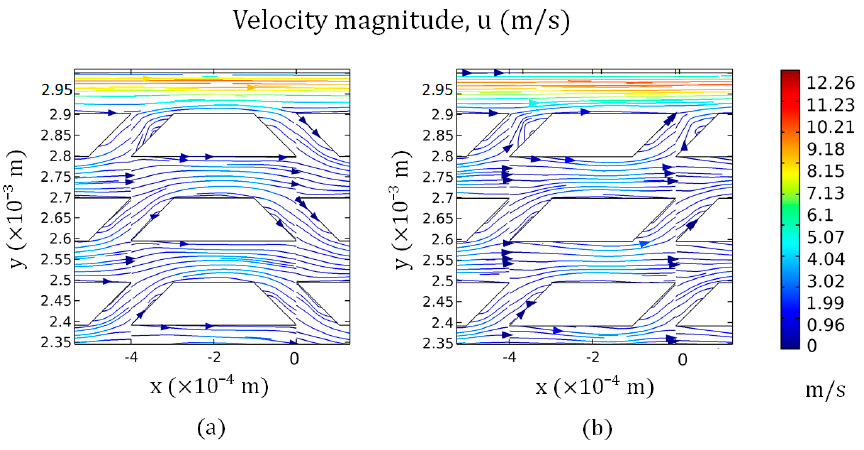
Figure 7. Streamlines over the midplane (z = 0) of the heat sink in the vicinity of x = − 2.0 × 10 − 3 m and y = 2.65 × 10 − 3 m for the Z-type inlet-outlet configuration with ( a ) regular trapezoidal secondary flow and ( b ) parallel secondary flow.